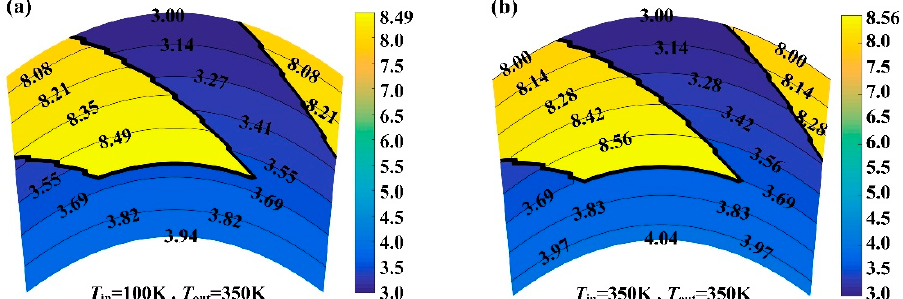
Figure 4. The distribution of the film thickness. (The yellow part is in microgrooves, the blue part is in the seal dam). ( a ) Temperature gradient condition; ( b ) Isothermal condition. ( P in = 5.0 MPa, P out = 0.1 MPa, n = 50,000 rpm, h 0 = 3 μ m).